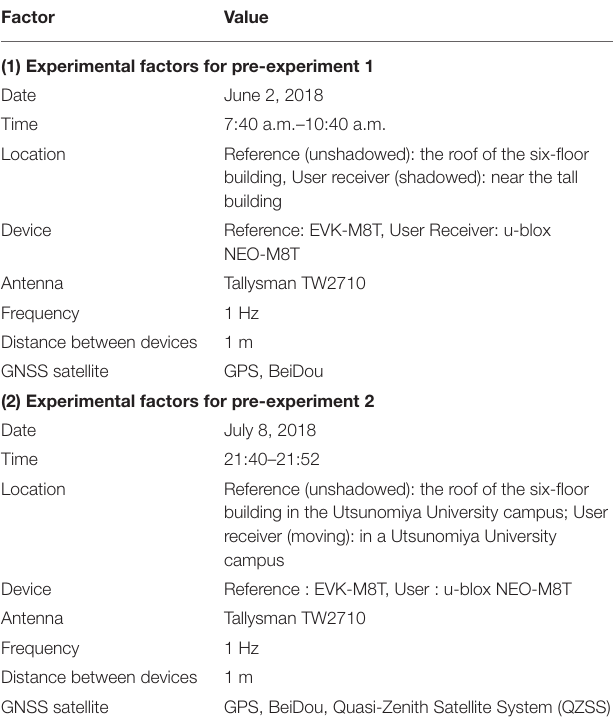
TABLE 2 | Experimental factors for pre-experiment 1 and